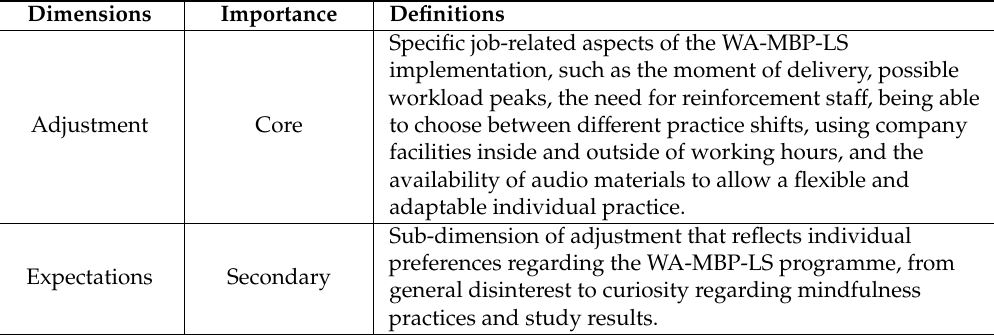
Table 6. Theoretical definitions for the dimensions of the qualitative